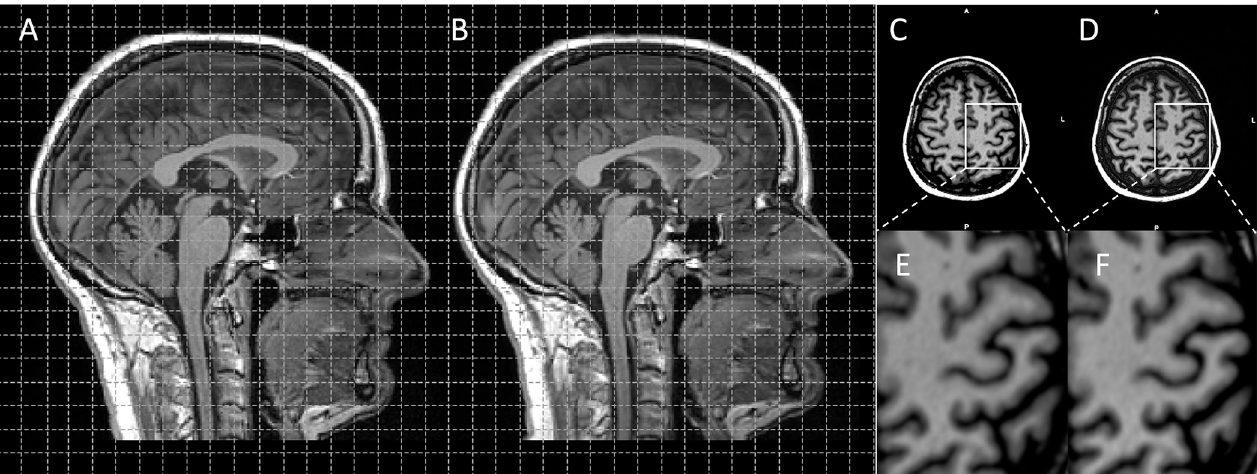
Fig 1. Example of T1w MPRAGE images in sagittal and axial plane with (A and C) and without (B and D) distortion correction. The distortion effects were most prominent in the central region but difficult to detect visually (E and F).